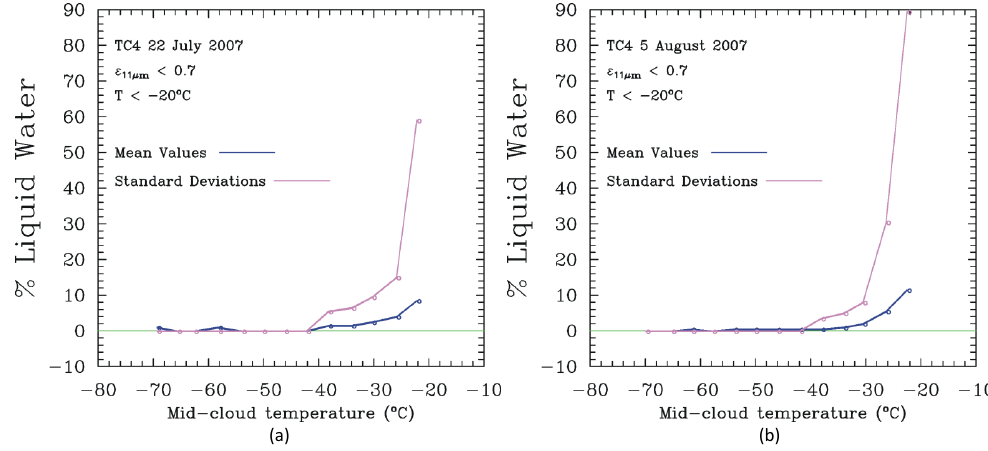
Fig. 8. Retrieved liquid fraction for clouds identified as single-layer cirrus for the two cloud scenes studied. Both means and standard deviations are plotted against retrieved temperature as described in the text. Cloud emissivities (at 11µm) and temperatures were less than 0.7 and − 20 ◦ C, respectively.